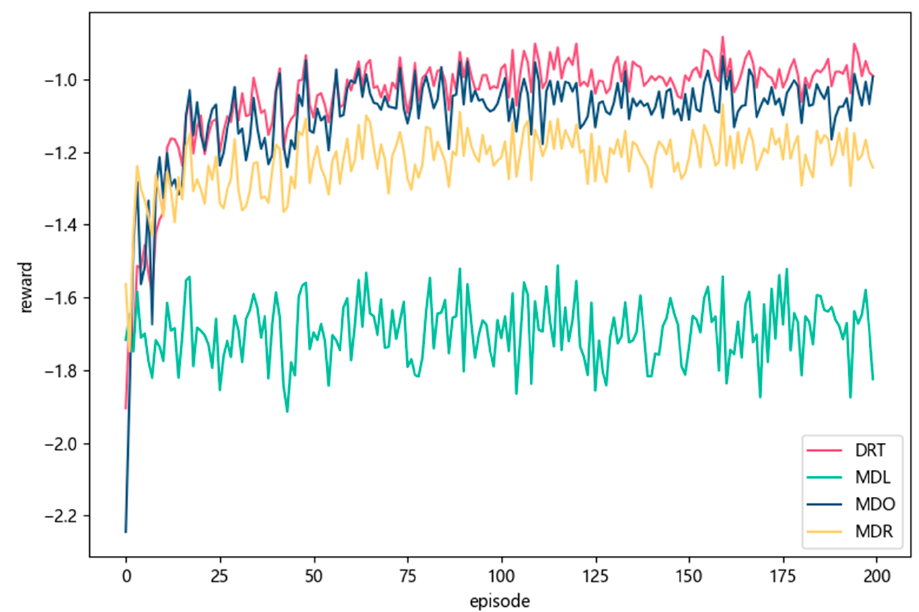
Figure 5. Comparison of reward with different strategies on MDs during training.